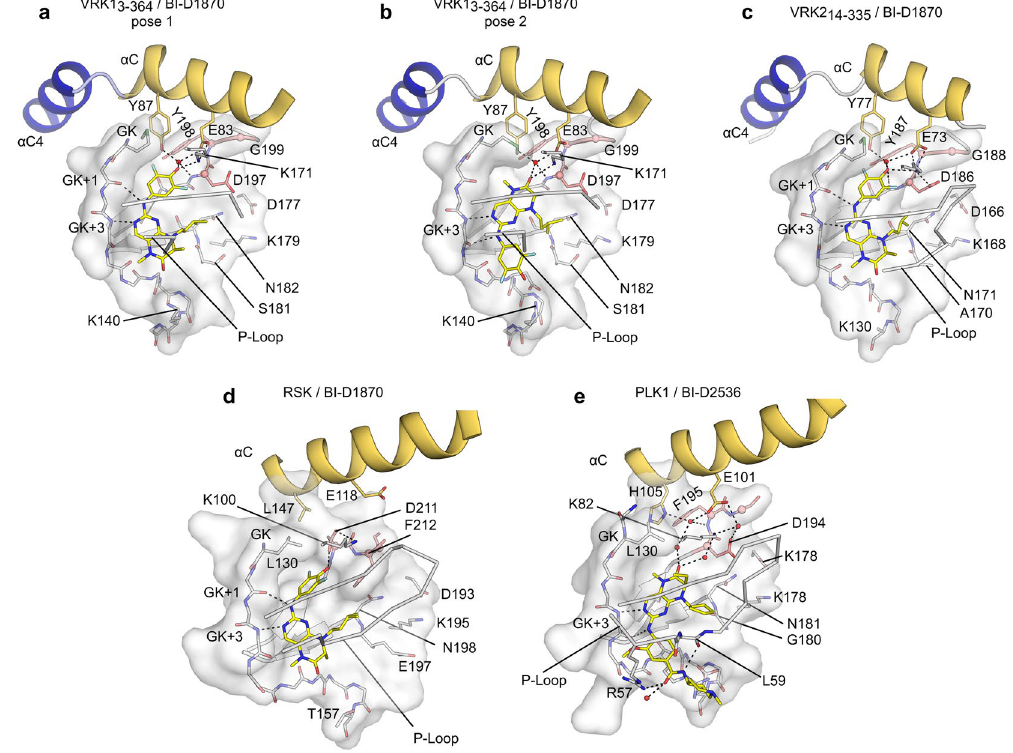
Figure 6. Active VRKs, PLK1 and RSK2 have dissimilar binding modes to pteridinone compounds. ( a , b ) BI- D1870 has two distinct binding modes to VRK1, supported by different interactions with the protein hinge region. ( c ) BI-D1870 interaction with VRK2. Both VRK1 and VRK2 are constitutively in a DFG-in, active conformation. ( d ) RSK2 binds to BI-D1870 in an inactive, DFG-out conformation (PDB:5DK9). ( e ) BI-D2536 binding mode to PLK1 (PDB:2RKU) is similar to pose 2 in VRK1 3-364 /BI-D1870 co-crystals. PLK1 residues at the back of the ATP-binding site (K82, E101 and D194) contact the compound via an extensive network